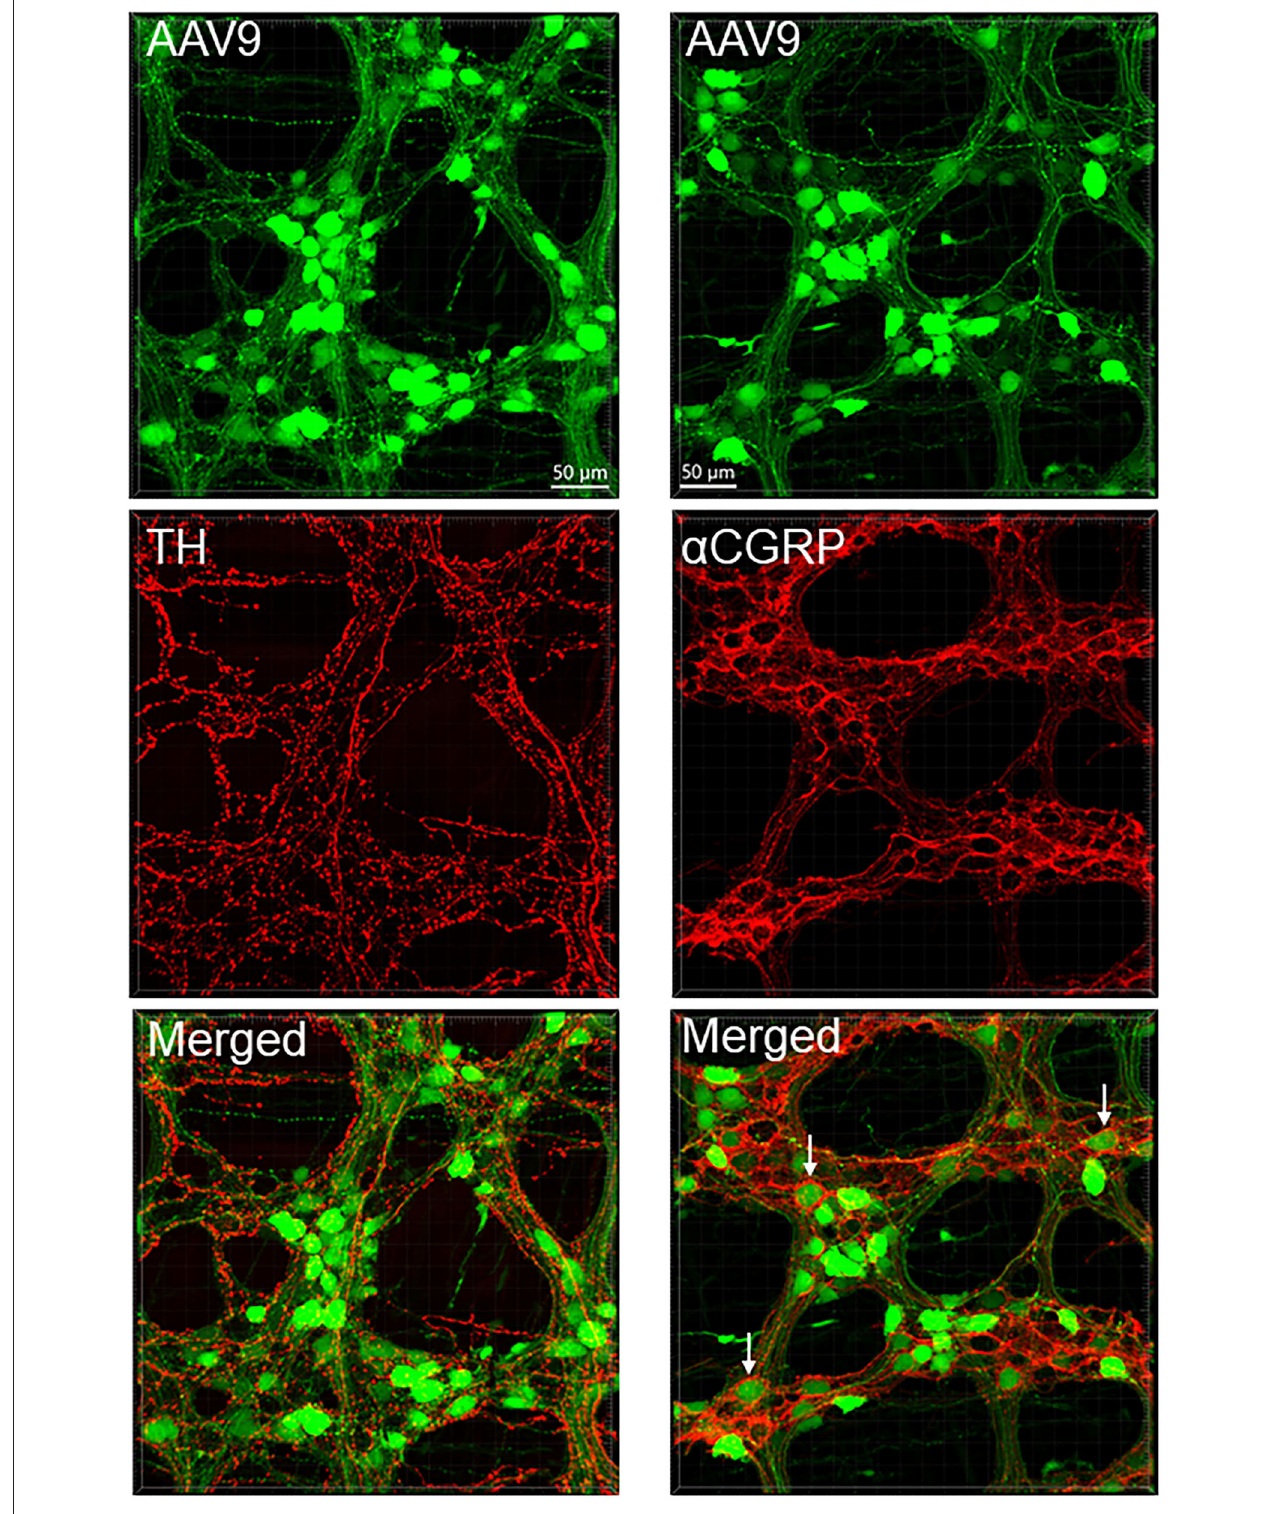
FIGURE 7 | AAV9 transduction in the myenteric plexus whole mount preparations of the mouse proximal colon combined with immunofluorescence of tyrosine hydroxylase (TH, left panels) and calcitonin gene related peptide-alpha ( α CGRP, right panels). AAV9-CAG-GFP was retro-orbitally injected at 3.3 x 10 11 GC/mouse 3 weeks before. TH and α CGRP immunofluorescence (red) barely co-existed with AAV9 (green). Notably, α CGRP immunofluorescent nerve fibers surrounded neuronal somas more frequently (arrows) than TH.